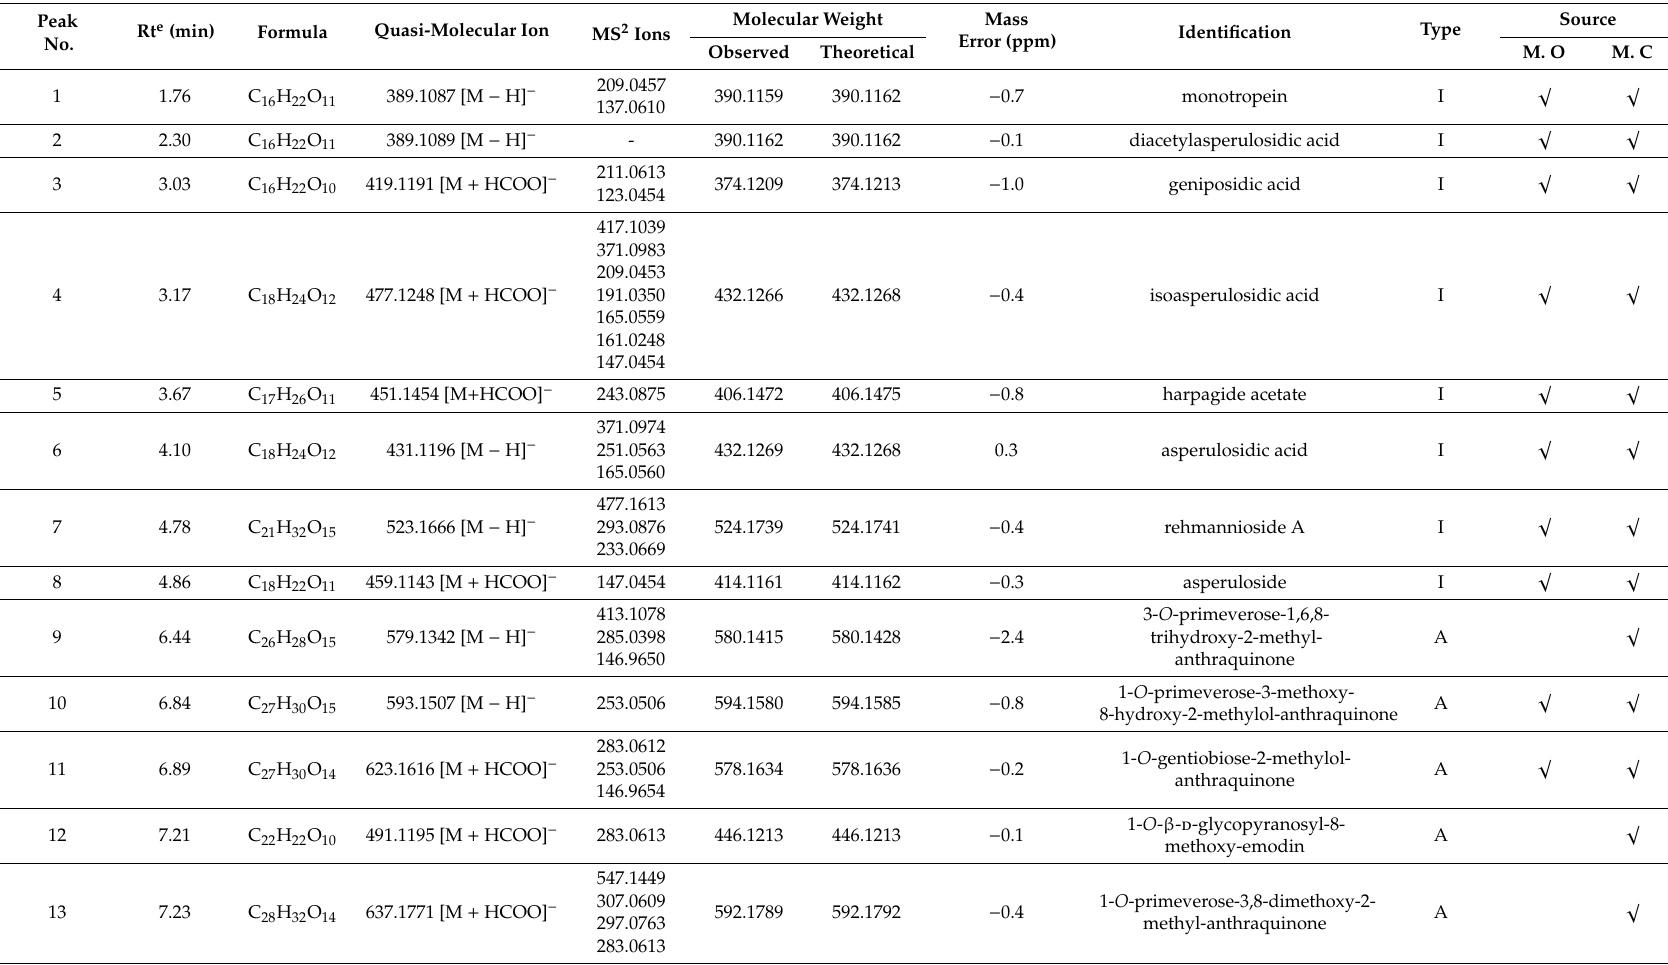
Table 1. The mass spectrometry data and identified chemical compounds from M. officinalis and M. citrifolia. Peak